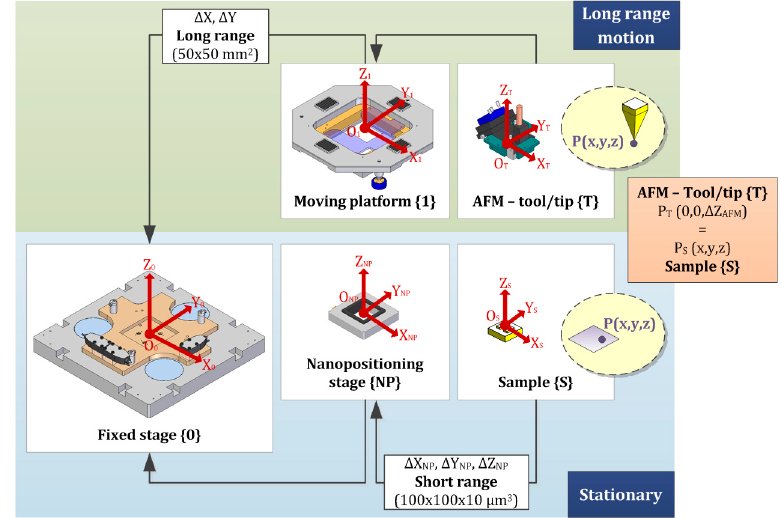
Figure 5. Schematization of the complete measurement loop of the NanoPla stage.